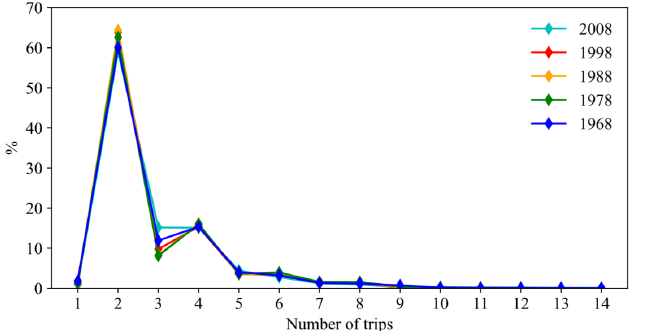
Figure 13. The percentages of numbers of trips by year (people without trips are excluded). The average numbers of trips are 2.88, 2.94, 2.83, 2.81, and 2.83 for 1968, 1978, 1988, 1998, and 2008, respectively.